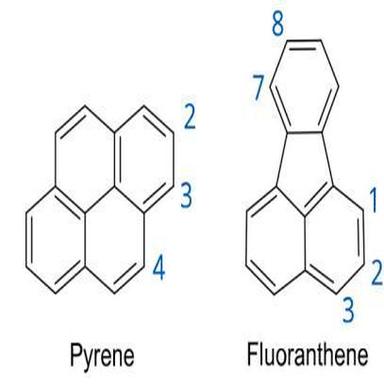
Pyrene and fluoranthene with the carbon atom labelling used in this work.